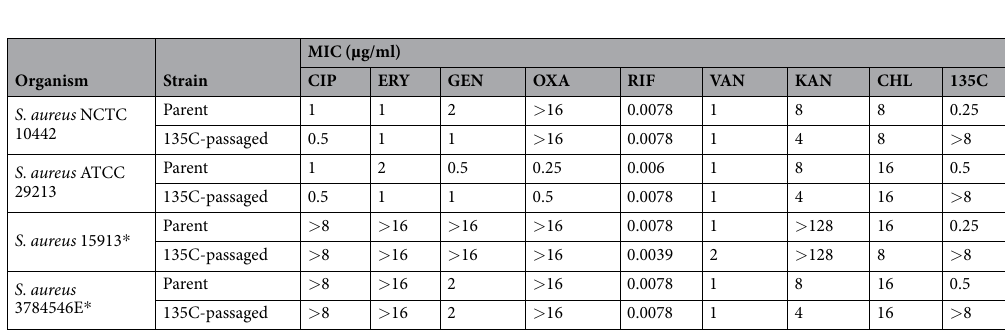
Figure 4. Growth fitness of serially passaged S. aureus isolates. The W indicates the wild-type strain and P indicates the passaged